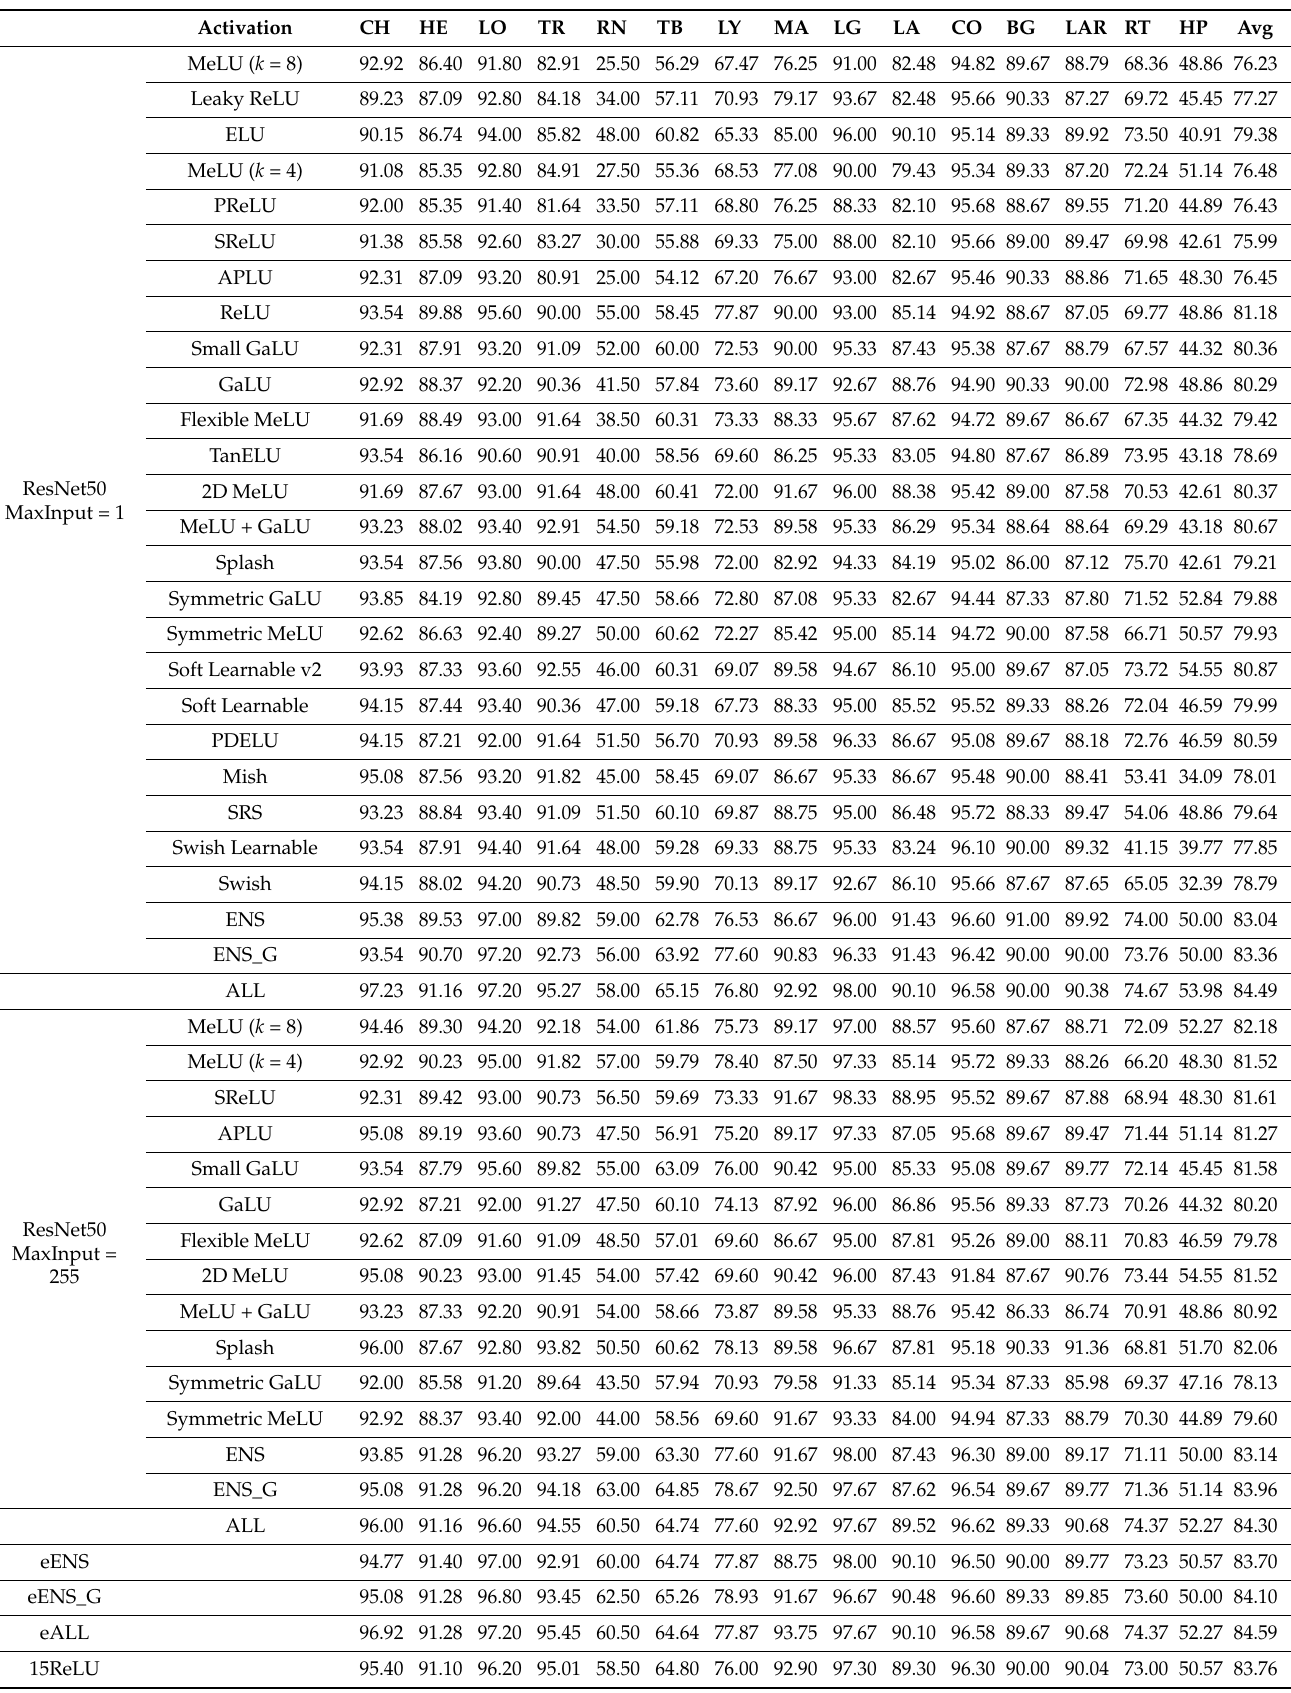
Table 4. Performance (accuracy) of activation function obtained using